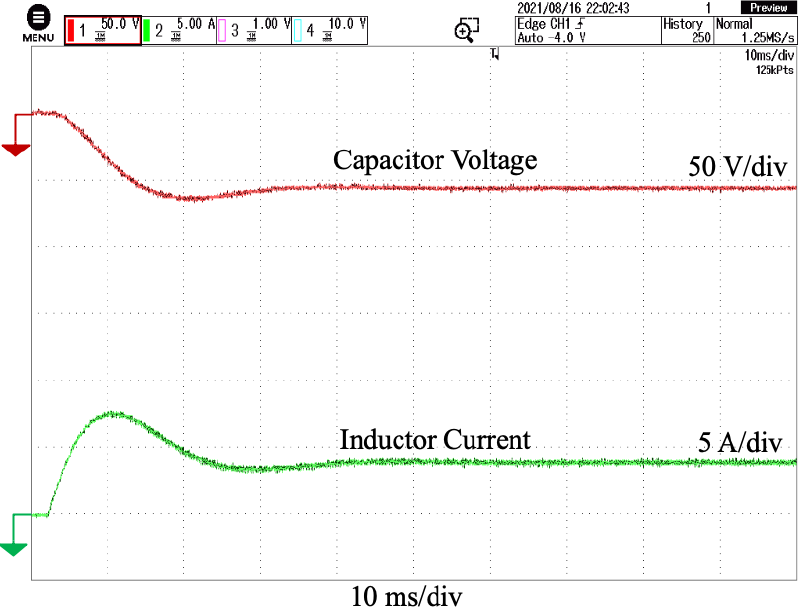
Figure 15. Experimental results of capacitor voltage and inductor current over continous time from S 3